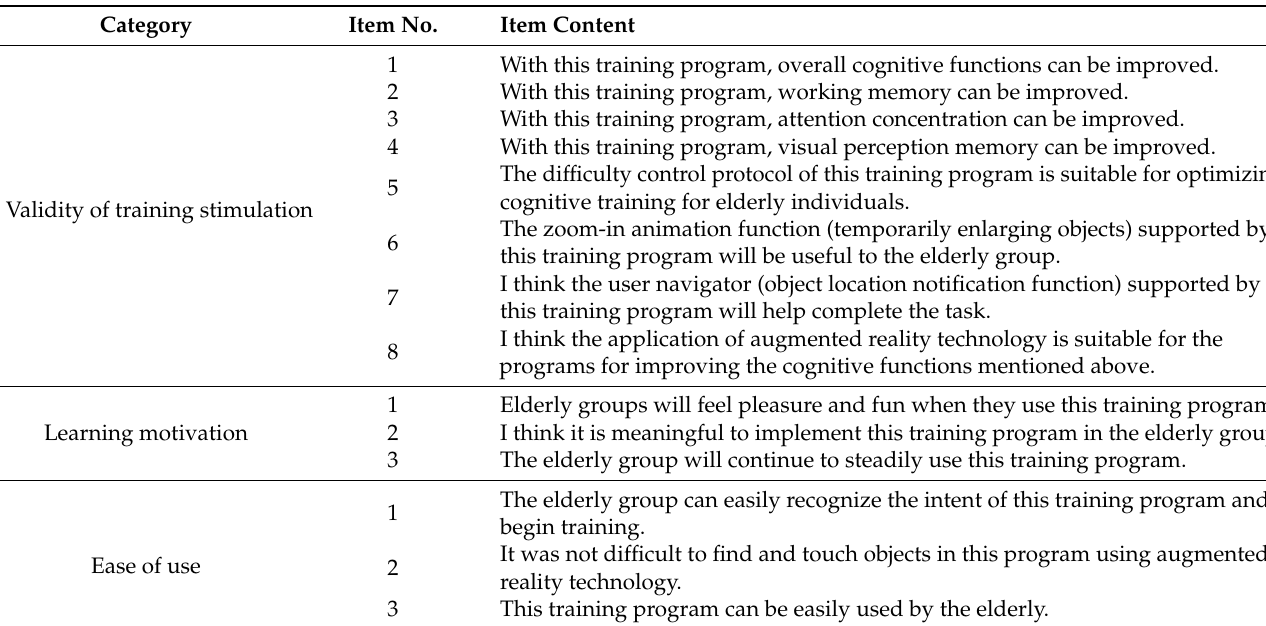
Table 2. Questionnaire for